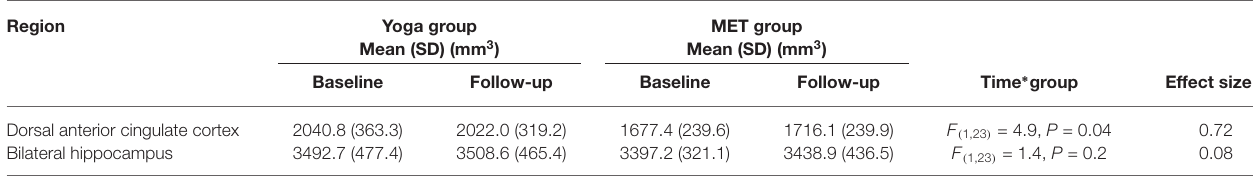
TABLE 2 | Magnetic resonance imaging (MRI) volumes for yoga and MET groups. Region